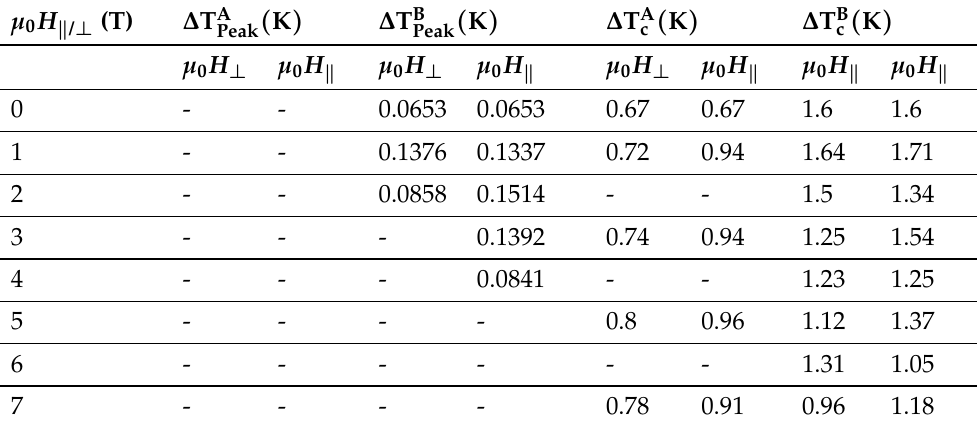
Figure 4. The behavior of the characteristic temperatures T onset function of ( a ) µ 0 H ⊥ . ( b ) µ 0 H (cid:107) . ( c ) Evolution of T onset Table 3. The full width and half maxima of the T Peak and ∆ T c estimated for samples #A and #B recorded for µ 0 H (cid:107) and µ 0 H ⊥